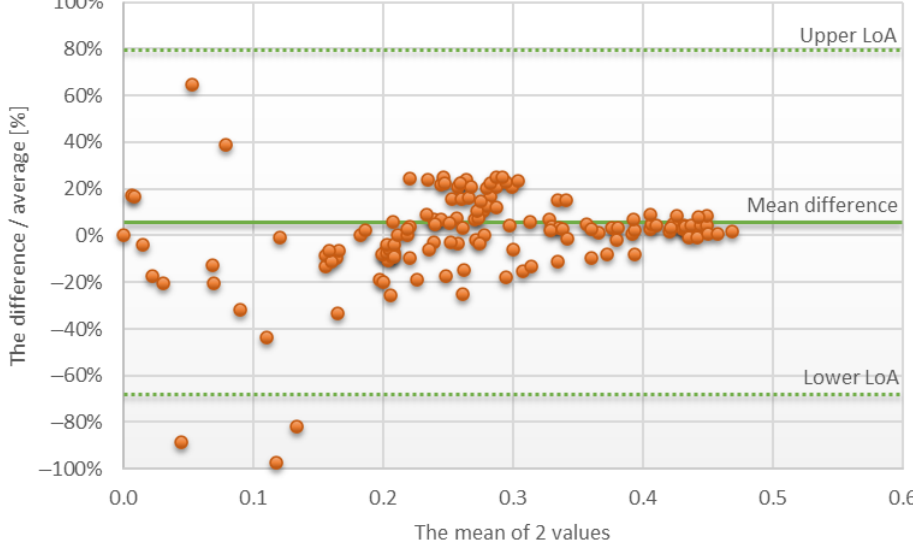
Figure 24. Plot of differences between methods, expressed as percentages of the values vs. the mean of the two measurements (deformation of left side of arch support frame).